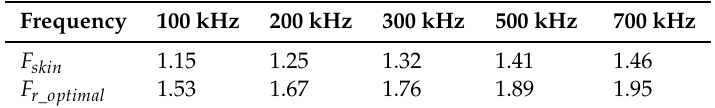
Table 1. The average F skin and calculated F r _ optimal of 2 Oz copper track with the track width varies from 4 mm to 5